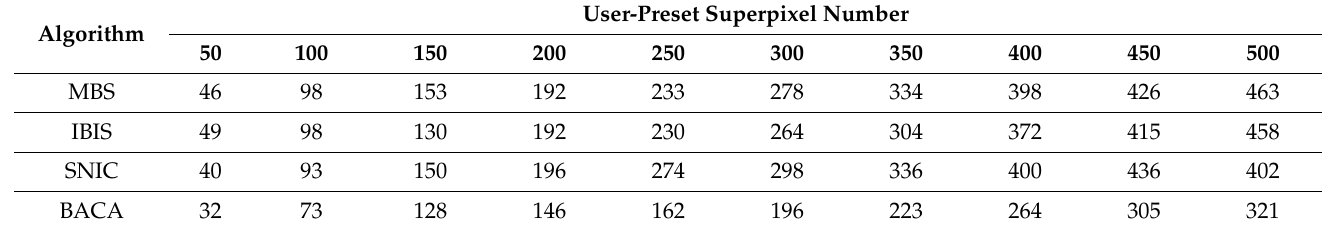
Table 3. Comparison of the superpixels number between actual generation and user-preset on the four